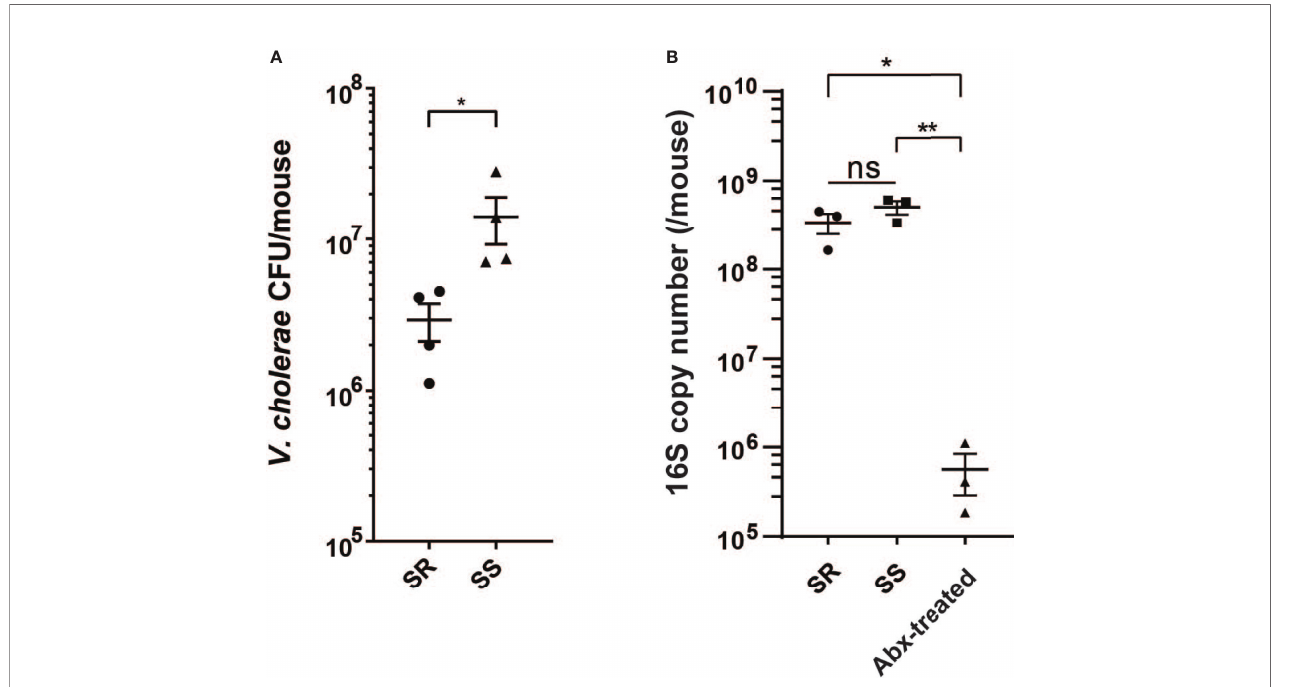
FIGURE 1 | V . cholerae colonization and fi tness varies with model commensal microbiota. (A) V. cholerae colonization of antibiotic-cleared 5-day-old suckling CD-1 mice after co-gavage with model microbial mixtures. (B) Bacterial 16S copy number in intestinal homogenates (n = 3 – 4, *P value < 0.05, **P value < 0.01, ns, not signi fi